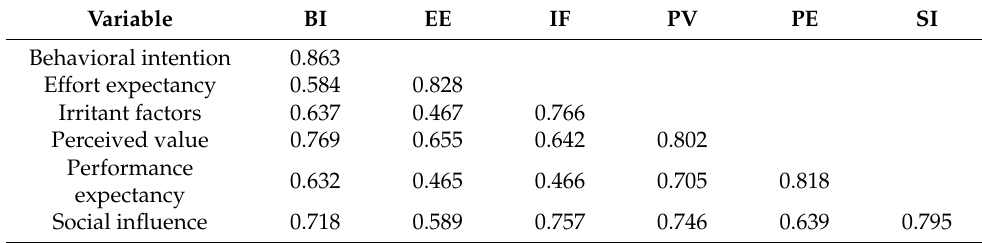
Table 4. Fornell and Larcker